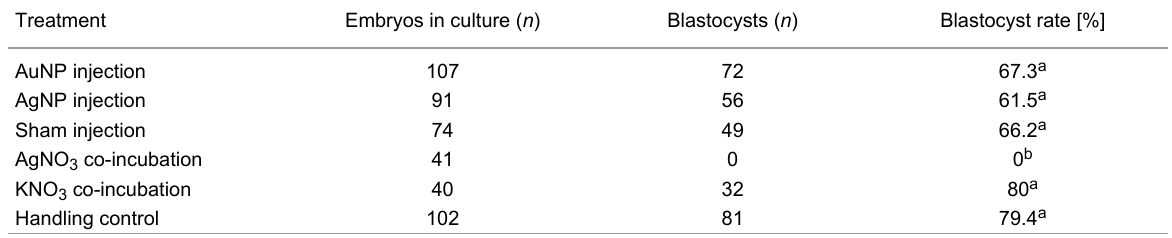
Table 2: Preimplantation development rates in the various treatment groups.